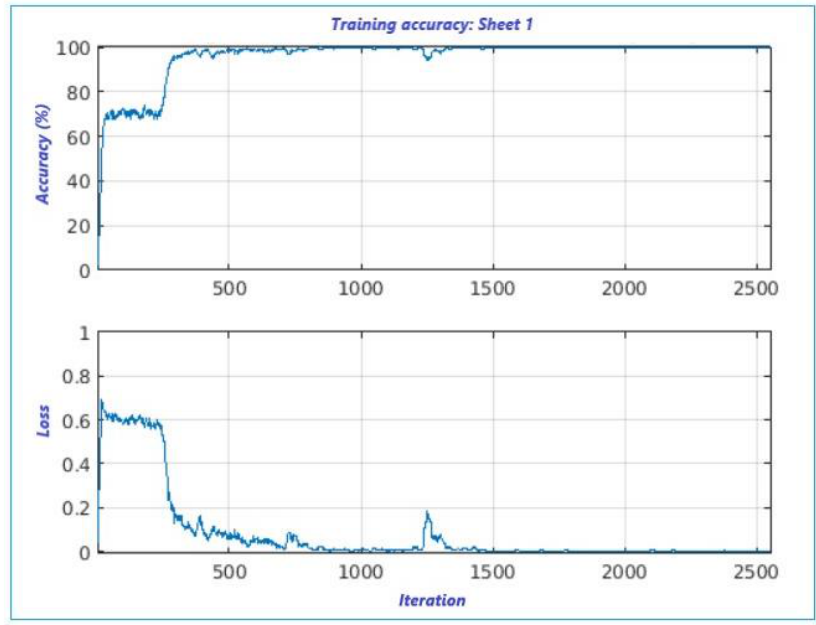
Figure 8. Proposed supervised leaning classification algorithm for sheet 1.